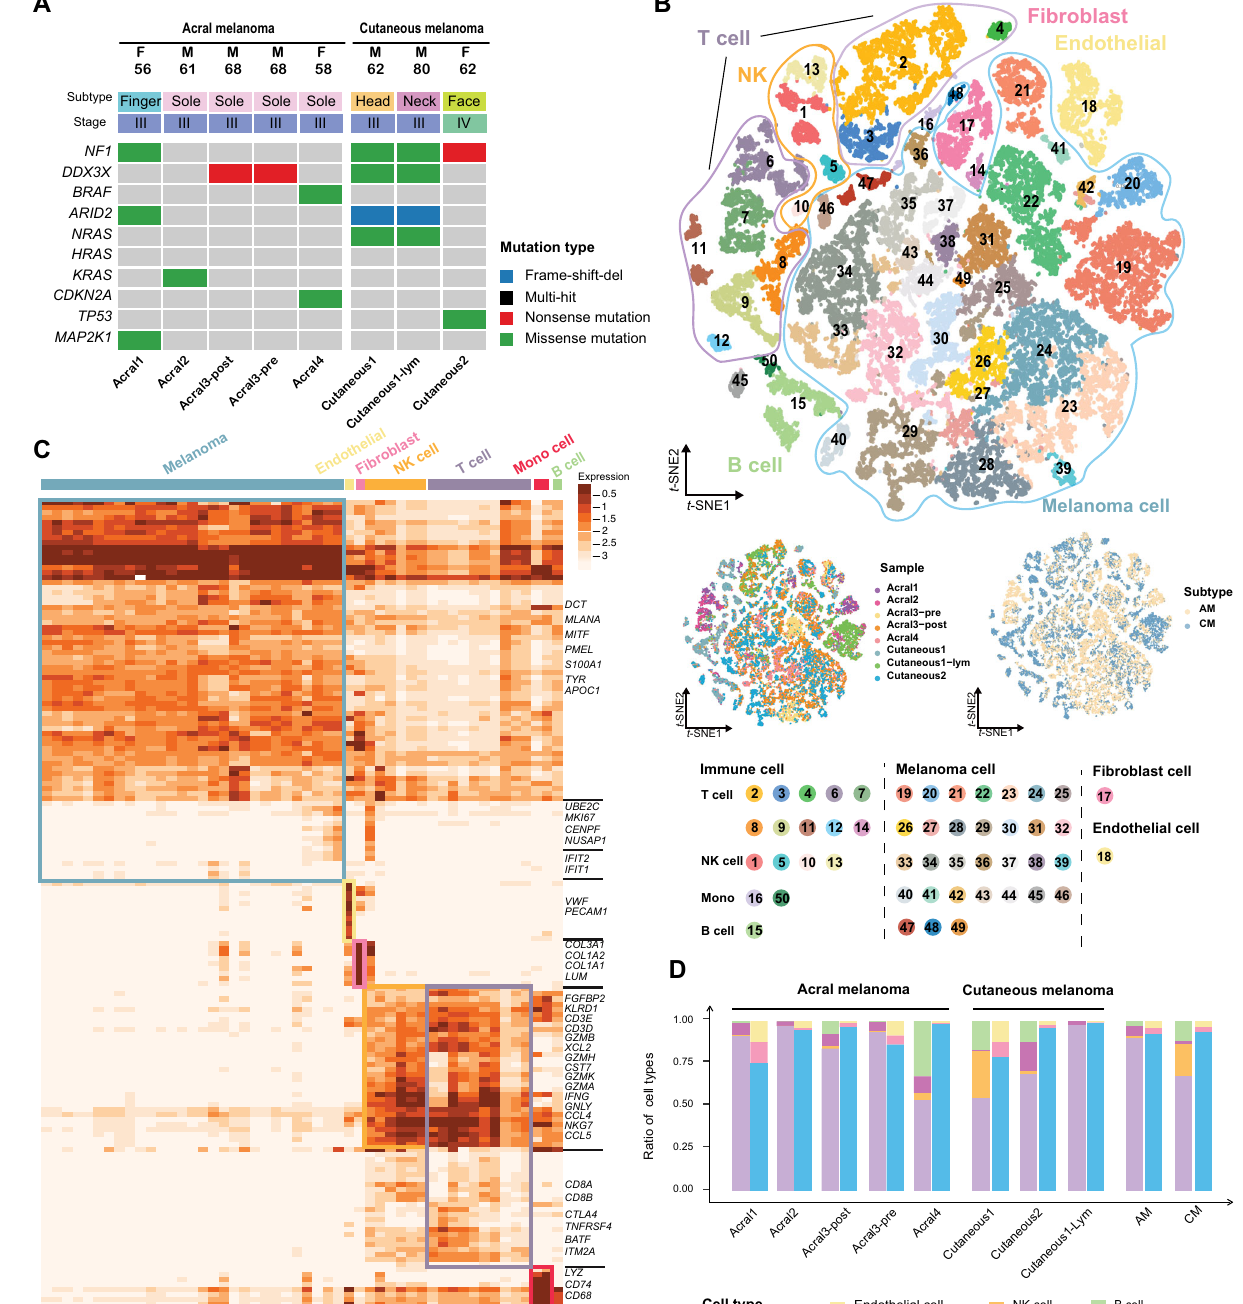
Fig.1|scRNA-seqpro fi lingoftheacralandcutaneousmelanomaenvironments. A Landscape of driver mutations and basic clinical information of 8 samples underwent single-cell sequencing. (F, Female. M, Male.) B T-distributed stochastic neighbor embedding (t-SNE) plot, showing the annotation and color codes for cell types in the melanoma ecosystem and cell origins by color, patient origin (left